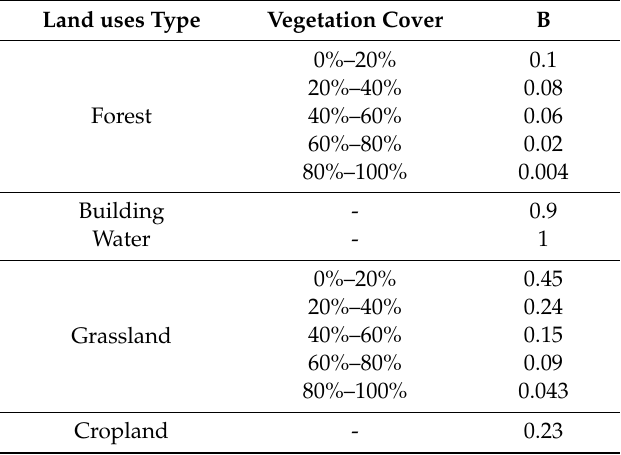
Table 2. B factor values with di ff erent land uses and vegetation cover.